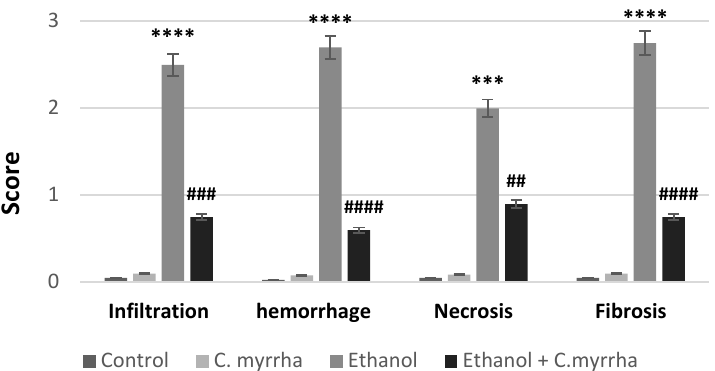
Figure 4. Semi-quantitative histopathological evaluation of the hepatic tissues from all experimental groups illustrating severity scores of lymphocyte infiltration, hemorrhage, necrosis, and fibrosis for experimental groups. *** p < 0.001; **** p < 0.0001 vs. control; ## p < 0.01; ### p < 0.001; #### p < 0.0001 vs. ethanol-treated group.